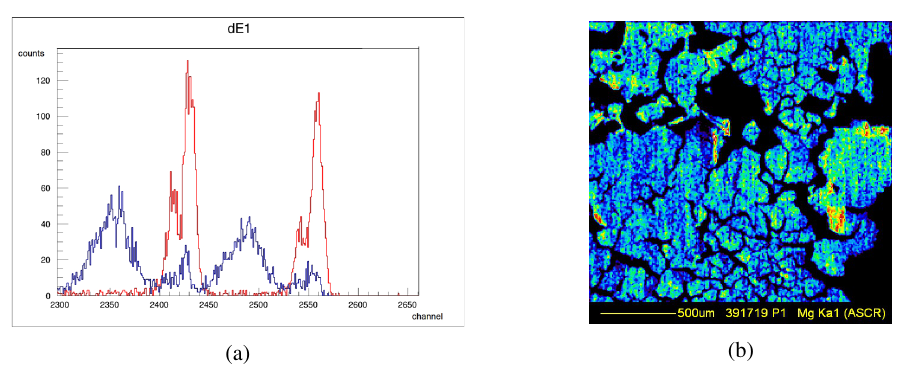
Figure 1: Analysis of magnesium layer thickness in target: (a) target thickness measurement with 244 Cm + 238 Pu alpha particle source; (b) RBS analysis of magnesium layer in the